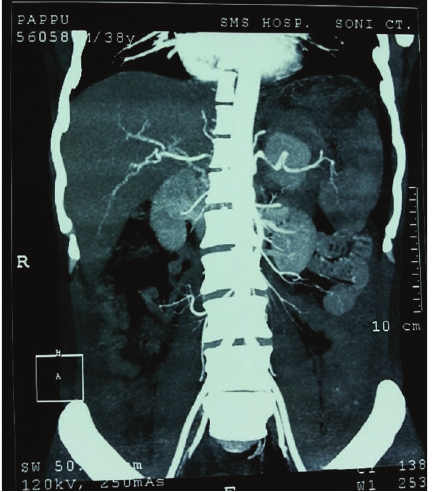
Figure 4: Triple phase CT finally giving the diagnosis of pseudoa-